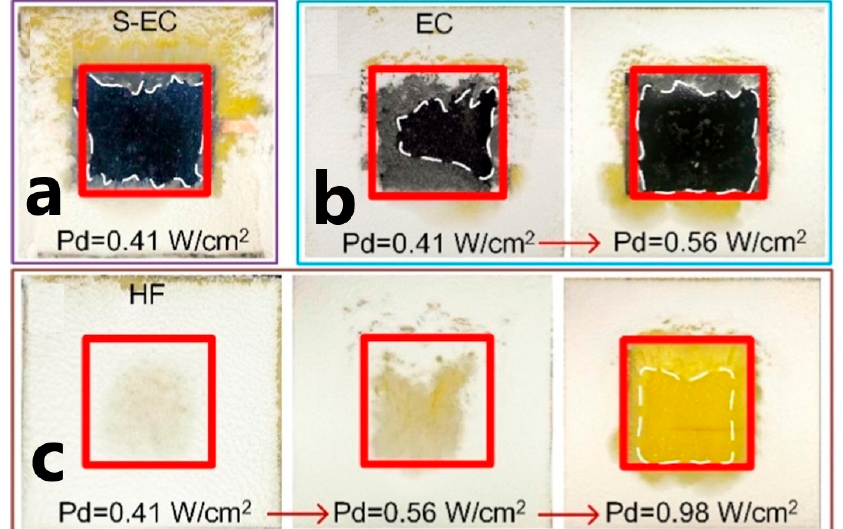
Figure 17. Anti-icing properties of coatings. ( a ) S-EC, ( b ) EC, and ( c ) HF. Areas indicated by red rectangles are heating areas, and white dotted lines are areas without ice (Reprinted with permission from Elsevier, copyright 2018) [158].